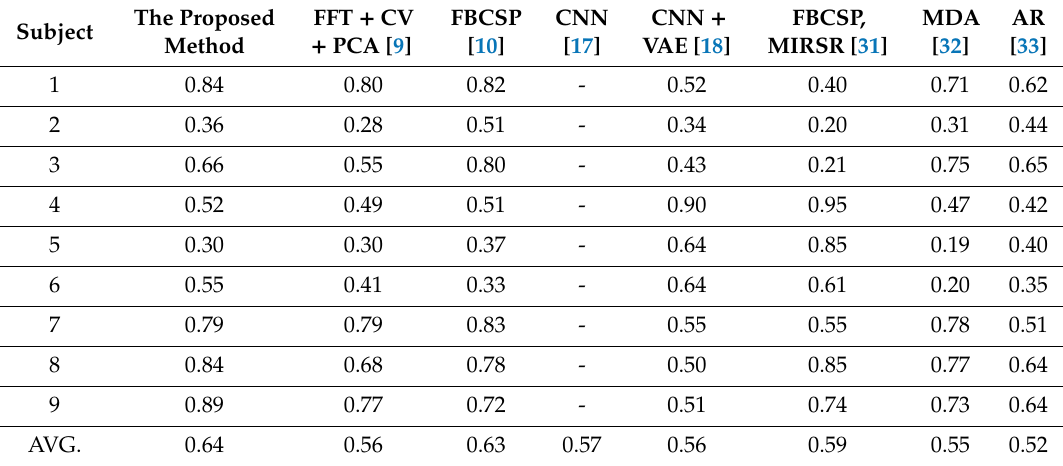
Table 5. Comparison of the results of the proposed method with the results of the state-of-art